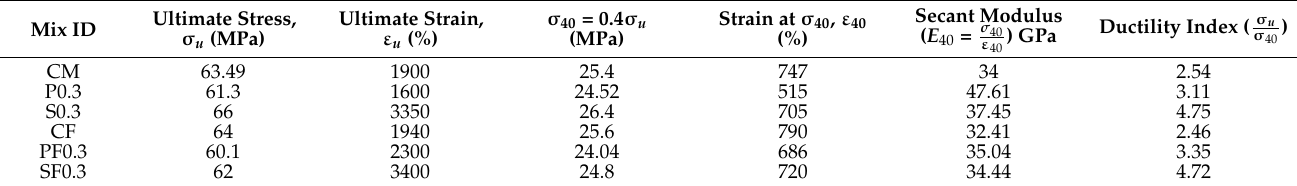
Table 6. Modulus of elasticity (E), and the ductility index of concrete determined according to BS EN 192-2-2 [34]. Mix